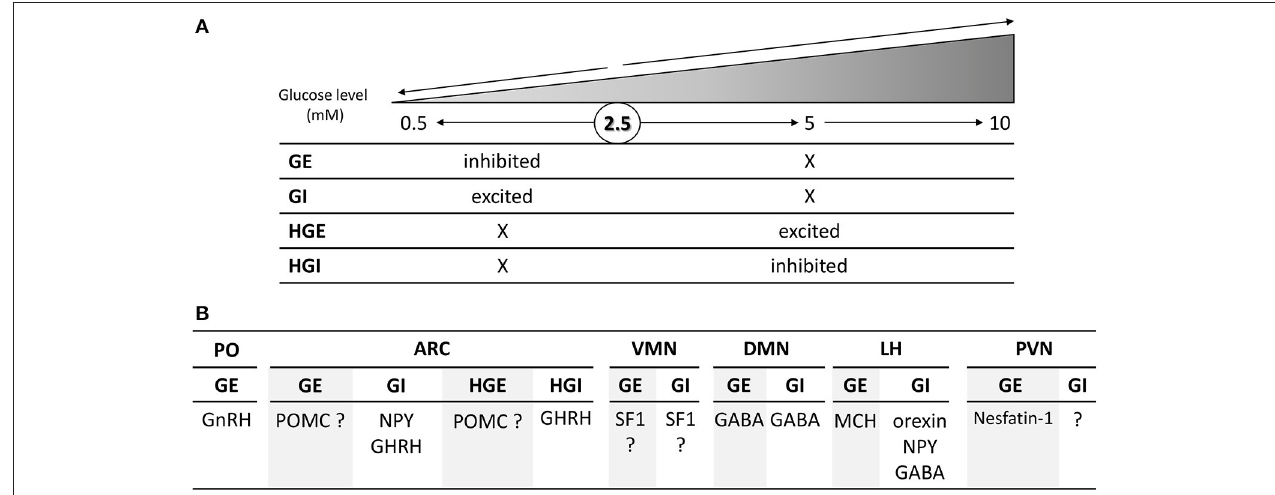
FIGURE 1 | Schematic overview of the changes in glucose level detected (A) and nature (B) of the four subtypes glucose-sensing neurons present in the hypothalamus. (A) GE and GI neurons are respectively inhibited and activated by changes in glucose level below 2.5mM and are non-sensitive to change above 2.5mM. By opposition, HGE and HGI neurons are respectively activated and inhibited by changes above 2.5 or 5mM while their activity is not altered by changes below 2.5mM. The symbol “X” means that the electrical activity is not changed in comparison to the basal activity at 2.5mM. (B) Nature of hypothalamic glucose-sensing neurons. ARC, arcuate nucleus; DMN, dorsomedian nucleus; LH, lateral hypothalamus; PVN, paraventricular nucleus; PO, pre-optic area; VMN, ventromedian nucleus. The symbol “?” means that the nature of glucose-sensing neurons has yet to be